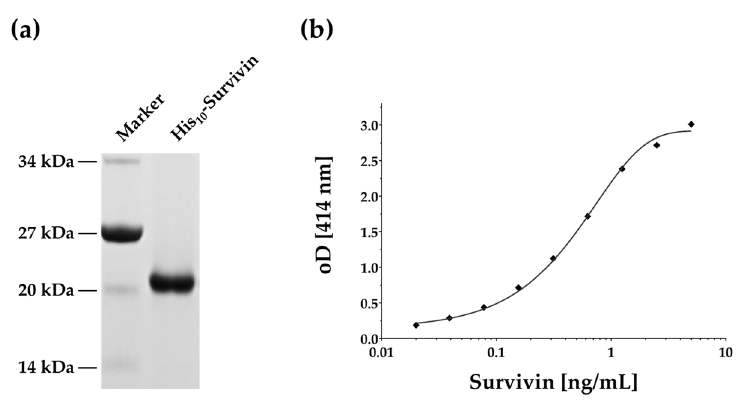
Figure 1. SDS-PAGE and ELISA reference curve. ( a ) Coomassie-blue stained SDS-PAGE of recombinant purified His 10 -survivin; ( b ) representative four-parameter logistic curve fit for the survivin ELISA.